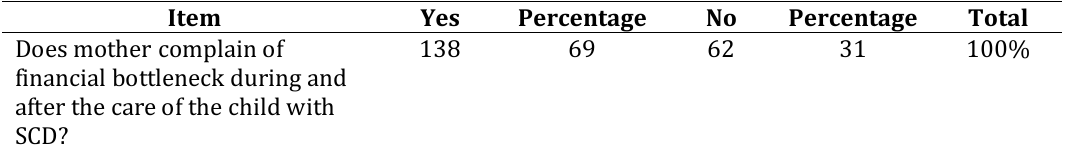
Does mother complain of financial bottleneck during and after the care of the child with SCD? Item